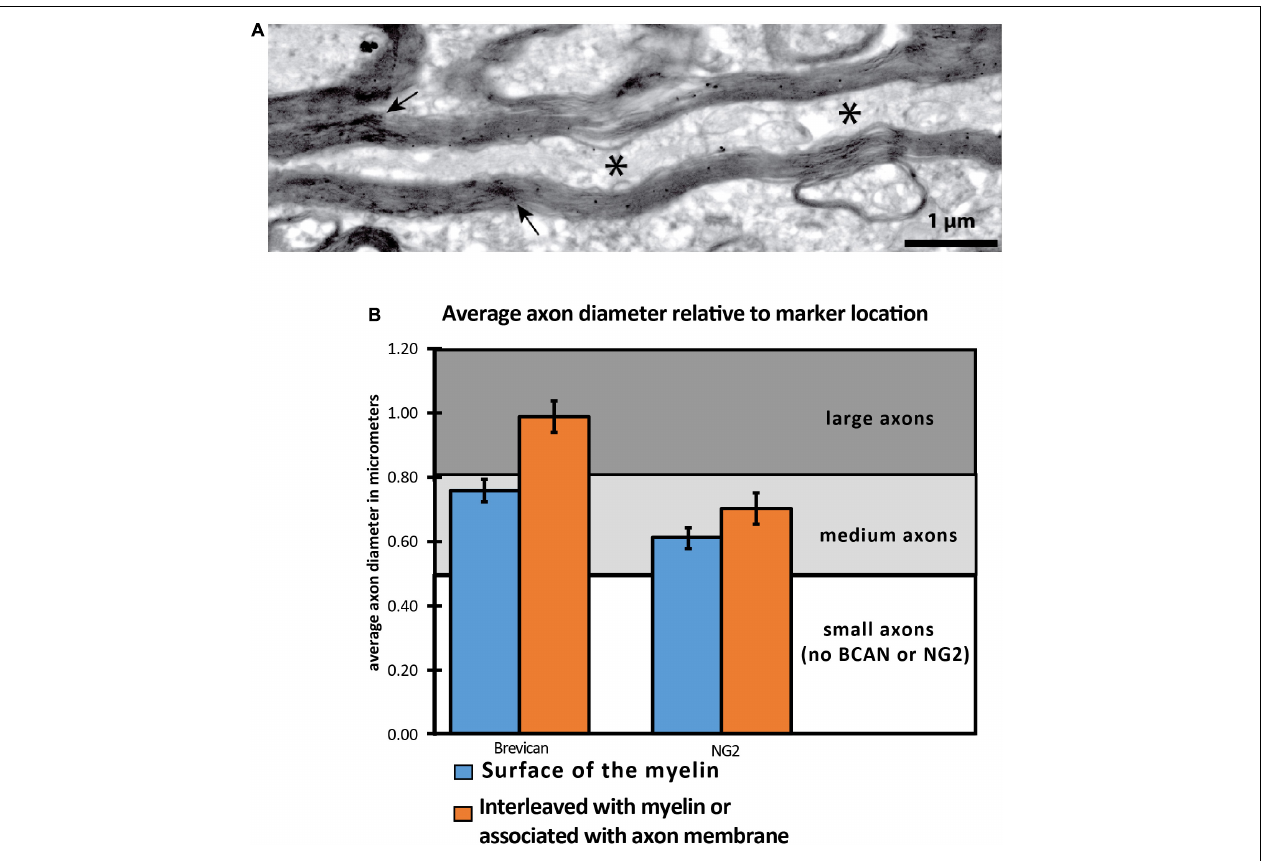
FIGURE 3 | NG2 and BCAN labeling is associated with larger axons. (A) Electron microscopy image depicting a cross-sectional axon with myelin labeling and interweaved immunoreactivity for NG2. (B) Two-dimensional quantitative analysis of 24,000 axon segments revealed that BCAN and NG2 labeling within the cytoplasm was more frequently observed in larger axons. The * symbol indicates location of the